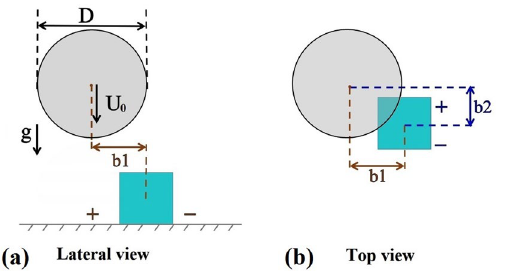
Figure 1. Schematic depiction of a droplet impacting onto a cubic pillar: definition of the droplet impact parameters and the collision parameters b 1 and b 2 with respect to ( a ) lateral view and ( b ) top view.